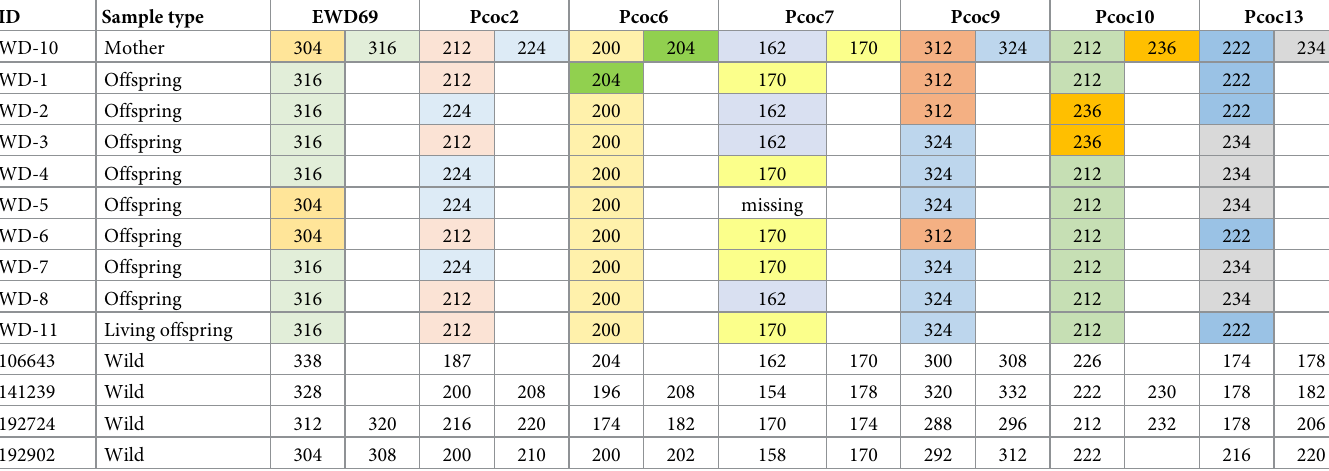
Table 4. Genotype data at seven microsatellite loci for 14 Asian Water Dragons. WD-1-11 are a mother Asian water dragon housed at the National Zoo, eight of her unhatched offspring, and a single hatched and living offspring. Asian water dragons from AMNH AMCC were also screened to confirm polymorphism of the microsatel- lite loci in four animals collected in